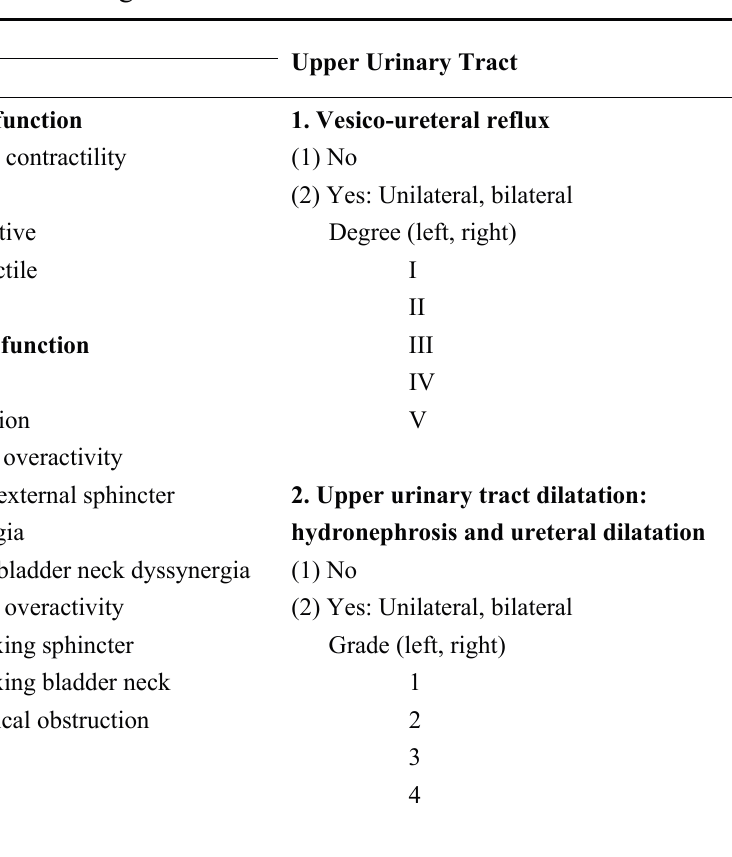
Table 1. Liao’s comprehensive classification system for lower and upper urinary tract dysfunction (LUUTD) in patients with neurogenic